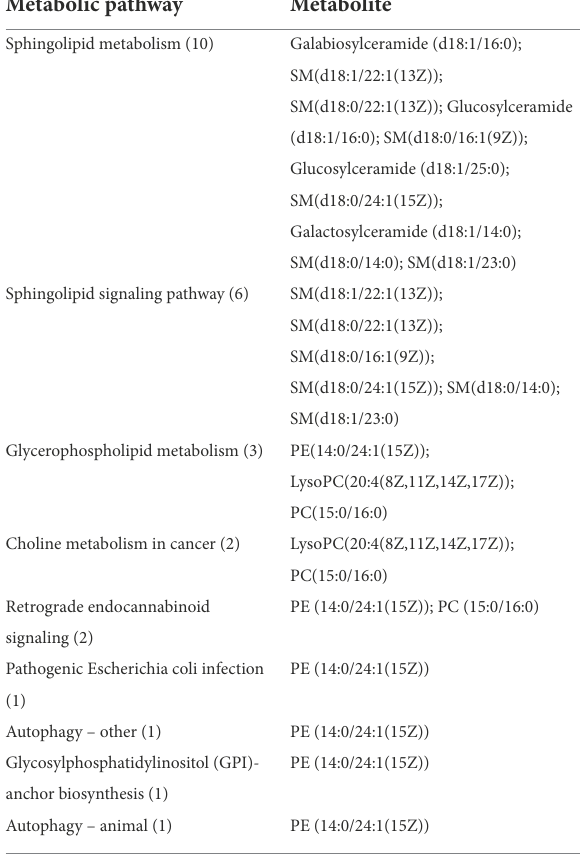
TABLE 5 Differences in metabolites enriched from specific pathways in milk of dairy cows receiving MCH infusions (7 days, n = 6). Metabolic pathway Metabolite Sphingolipid metabolism